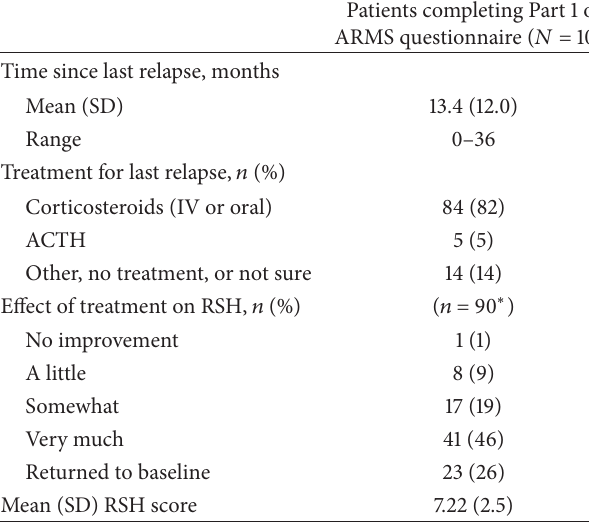
Table 3: Outcome for last relapse. Patients completing Part 1